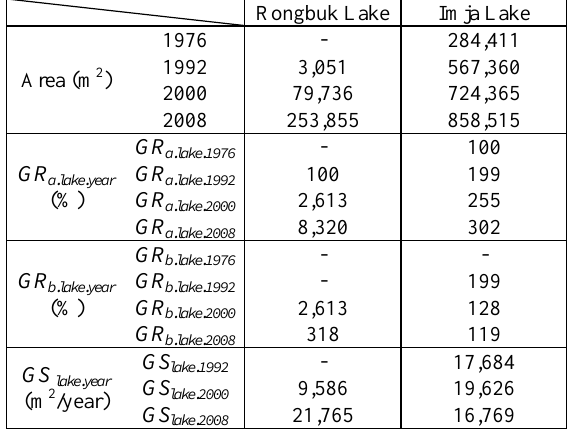
Table 1. Area, Growth rate, and Growth speed between Rongbuk Lake and Imja Lake